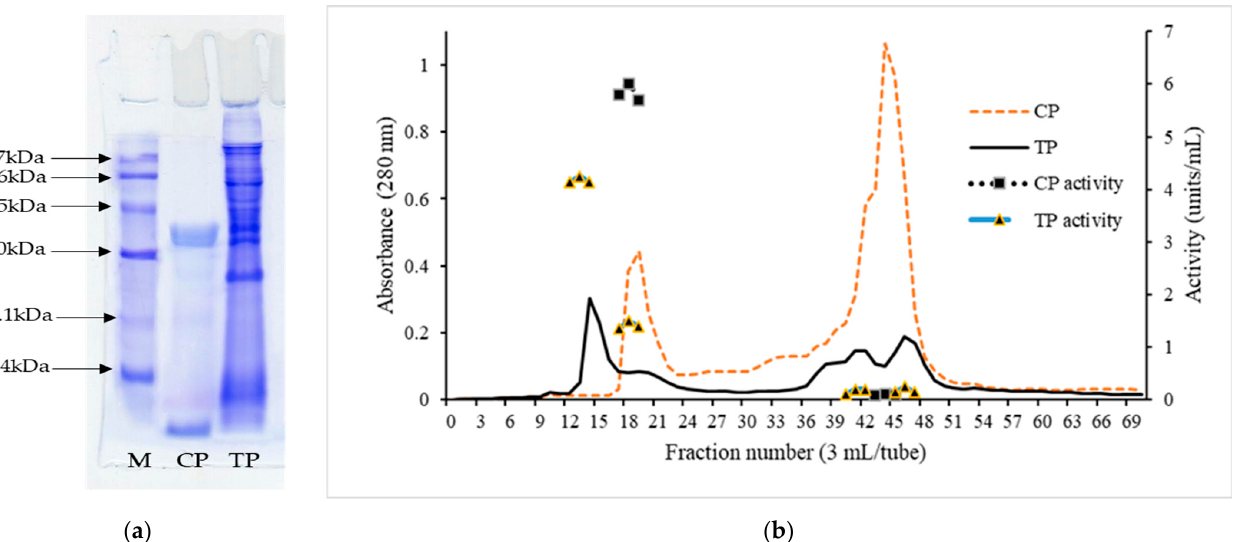
Figure 5. ( a ) Electrophoretic pattern of commercial pepsin (CP) and crude tuna pepsin (TP). Low- molecular-weight marker (M); ( b ) Molecular weight distribution by gel filtration and proteolytic activity of CP and TP.